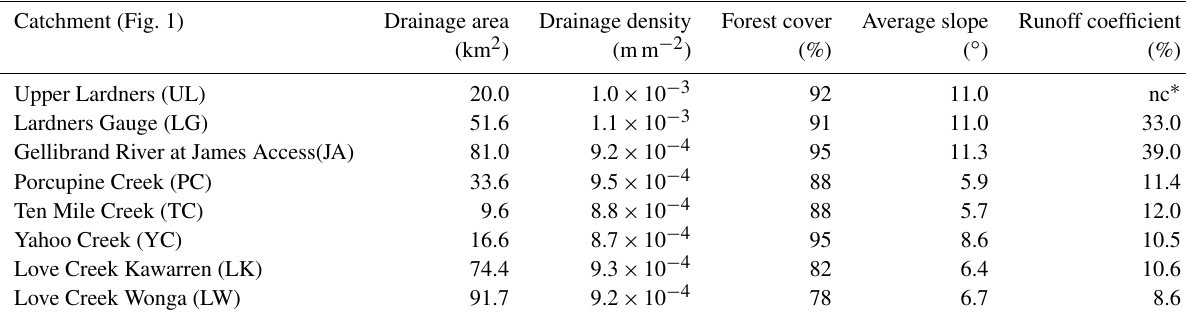
Table 1. Summary of the attributes of the upper Gellibrand River catchments. Catchment (Fig. 1) Drainage area Drainage